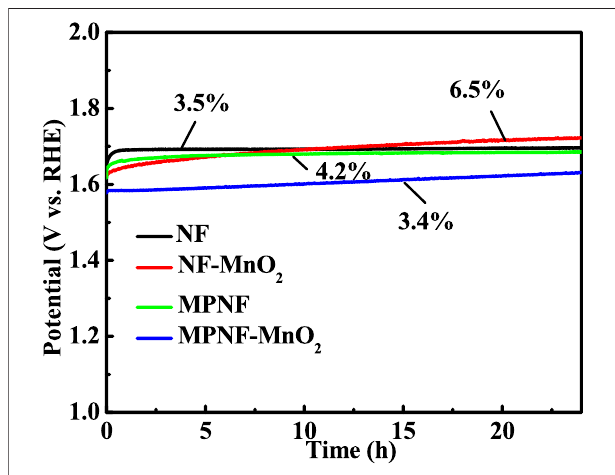
FIGURE 5 | The long-term stability of the MPNF-MnO 2 and NF-MnO 2 electrodes at a constant current density of 10 mA cm − 2 for 24 h.